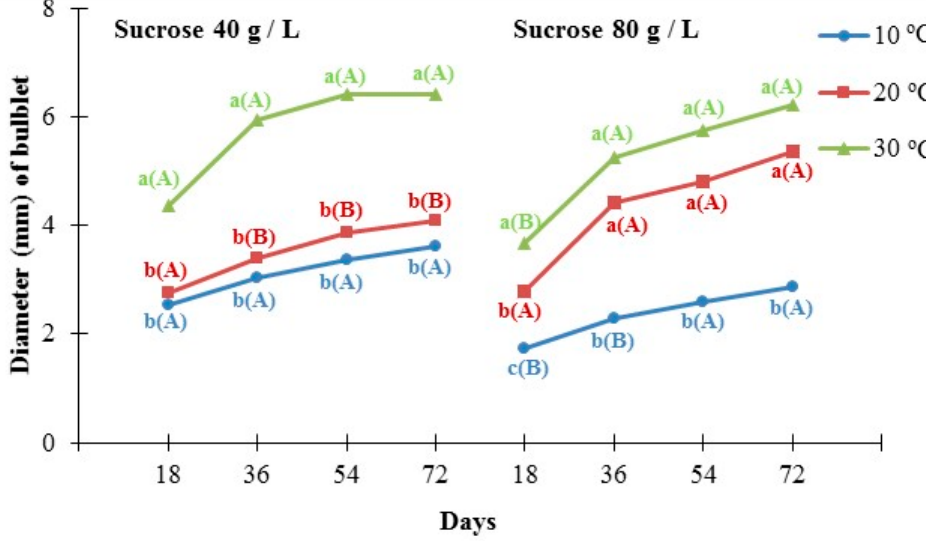
Figure 4. Effect of two different concentrations of sucrose (40 g/L and 80 g/L) at three different temperatures (10 ◦ C, 20 ◦ C, and 30 ◦ C) on the diameter of Pancratium maritimum bulblets produced in culture media In each sucrose concentration and each day of measurement, the same lowercase letters indicate non statistically significant differences among the temperature treatments, according to LSD test ( p ≤ 0.05). In each temperature and each day of measurement, the same uppercase letters in parenthesis indicate no statistically significant differences between sucrose concentrations, according to Student’s t -test ( p ≤ 0.05). Four replicates of five explants for each treatment.